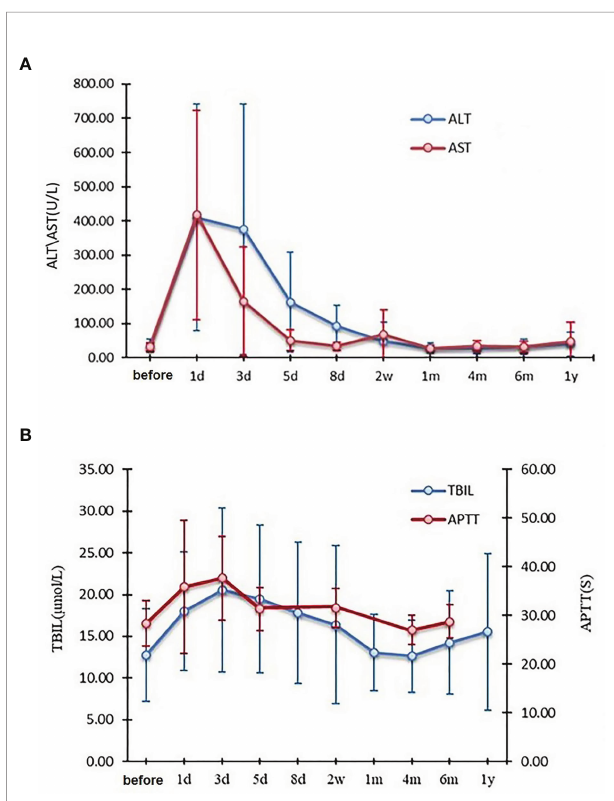
FIGURE 3 | Changes in ALT and AST (A) , TBIL and APTT (B) before and after narrow-margin resection combined with IOERT treatment. IOERT, Intraoperative Electron Radiotherapy; ALT, alanine aminotransferase; AST, aspartate transaminase; TBIL, total bilirubin; APTT, activated partial coagulation time.